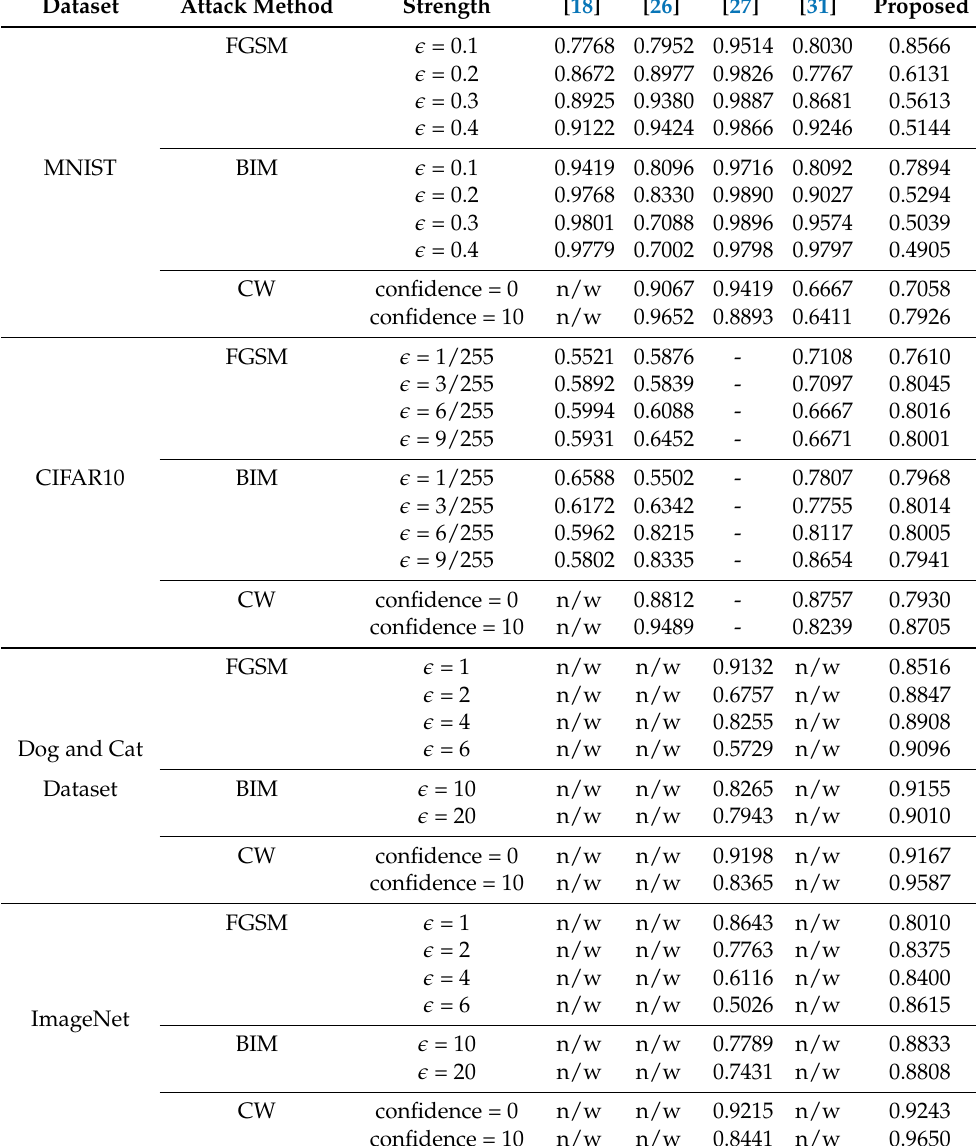
Table 1. Comparison of detection accuracy between different detection methods. Here ‘n/w’ stands for ‘Not working’, while ‘-’ stands for